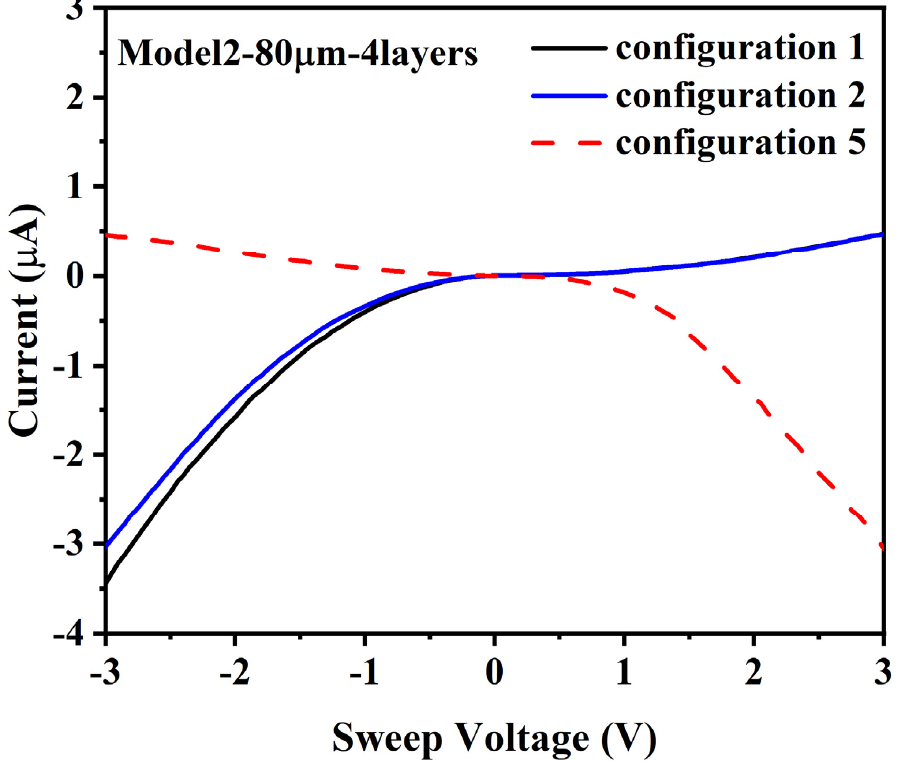
Figure 5. I/V curves for 80 µm gap, 4-layer test specimen: ( a ) (configuration 1) sweep voltage applied to A1, B1–B3 grounded; ( b ) (configuration 2) sweep voltage applied to A1, B1 grounded, B2, and B3 float; ( c ) (configuration 5) sweep voltage applied to B1–B3, A1 grounded.